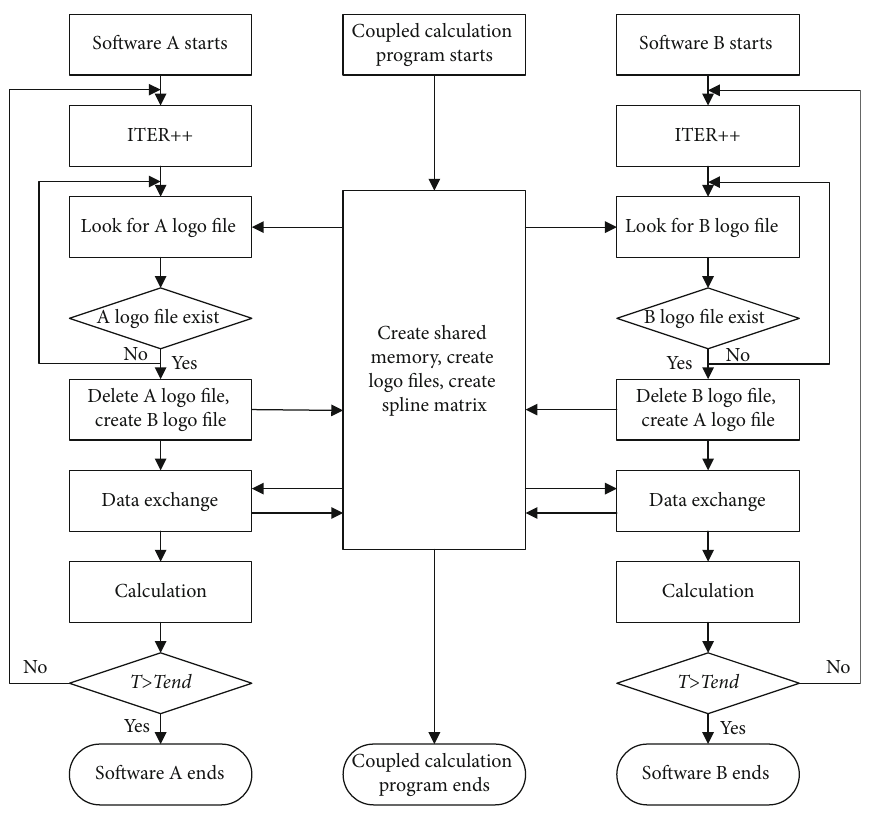
Figure 7: Coupling simulation fl